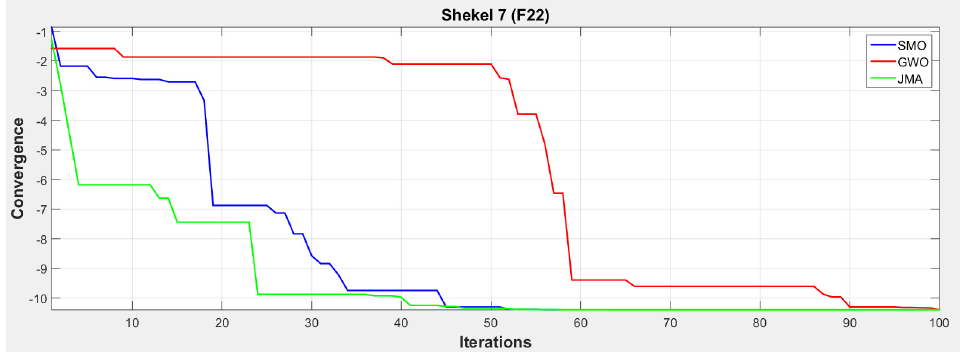
Figure 4. Convergence curve for Shekel 7 Function